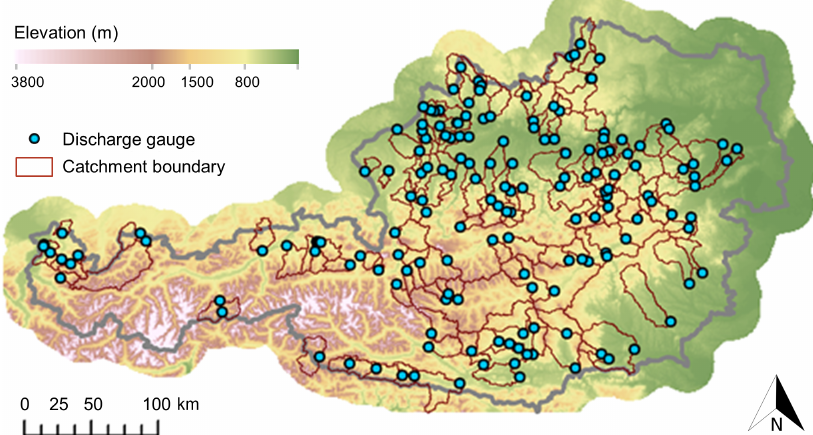
Figure 1. Distribution of the study catchments in